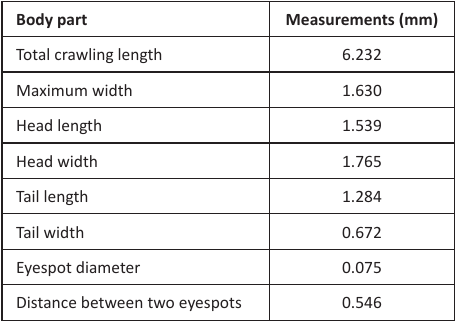
Table 1. Morphometric